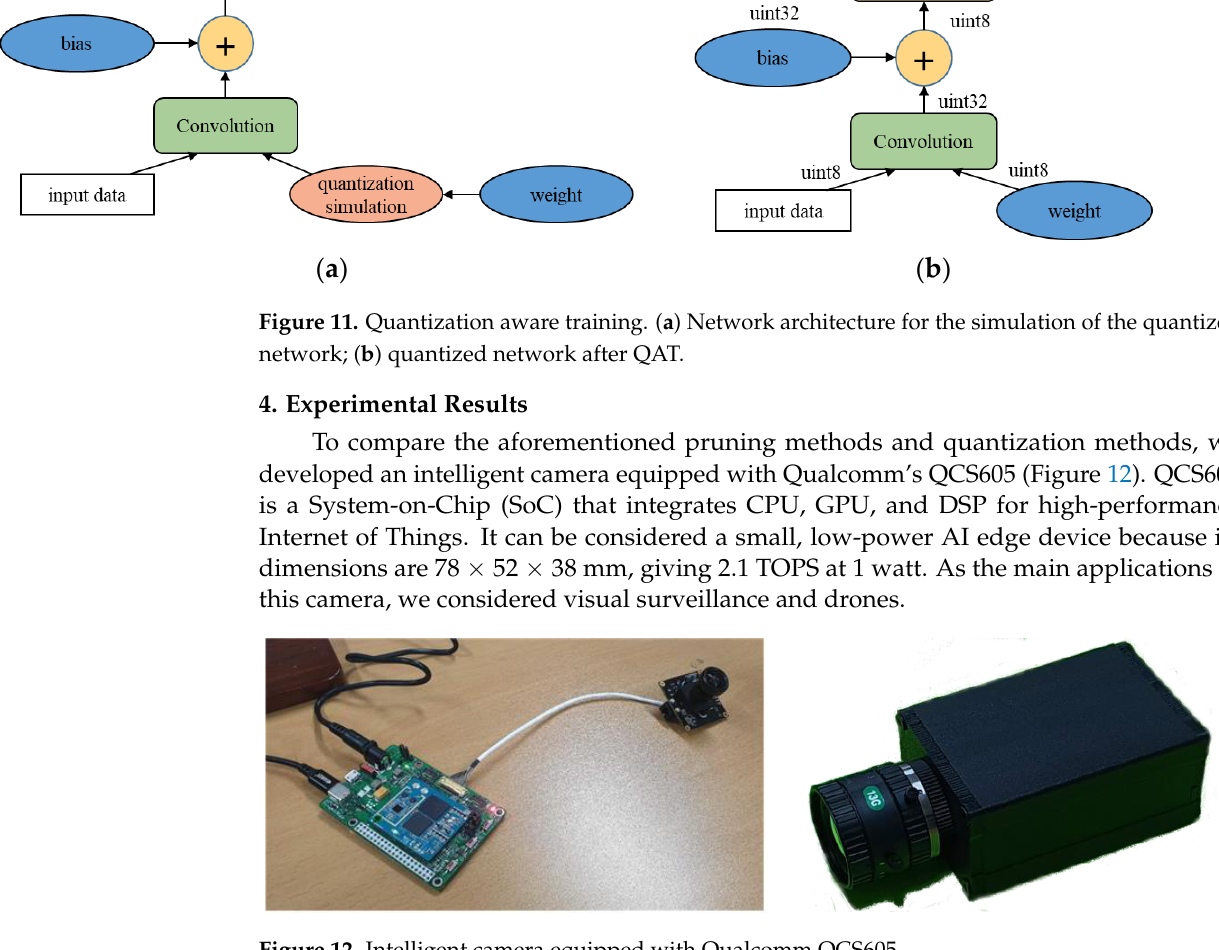
Figure 12. Intelligent camera equipped with Qualcomm QCS605.